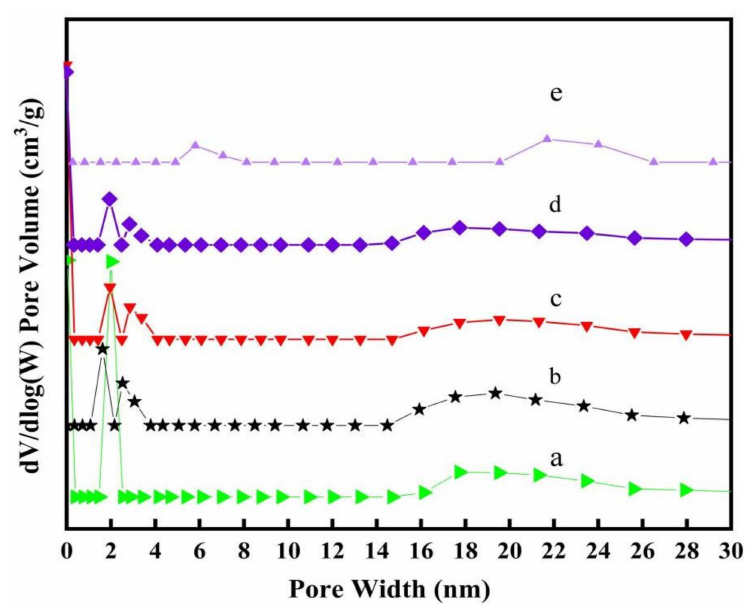
Figure 7. Pore size distribution of pure ZSM-5 ( a ) and composite products with different Zn/Si ratios